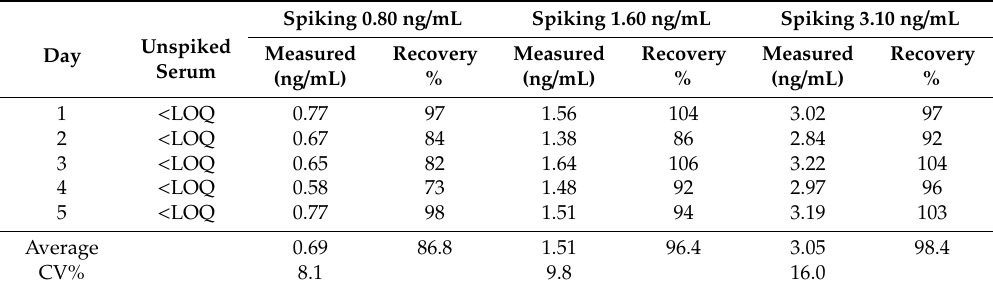
Table 3. Interday precision of the test with ZVNS1-spiked